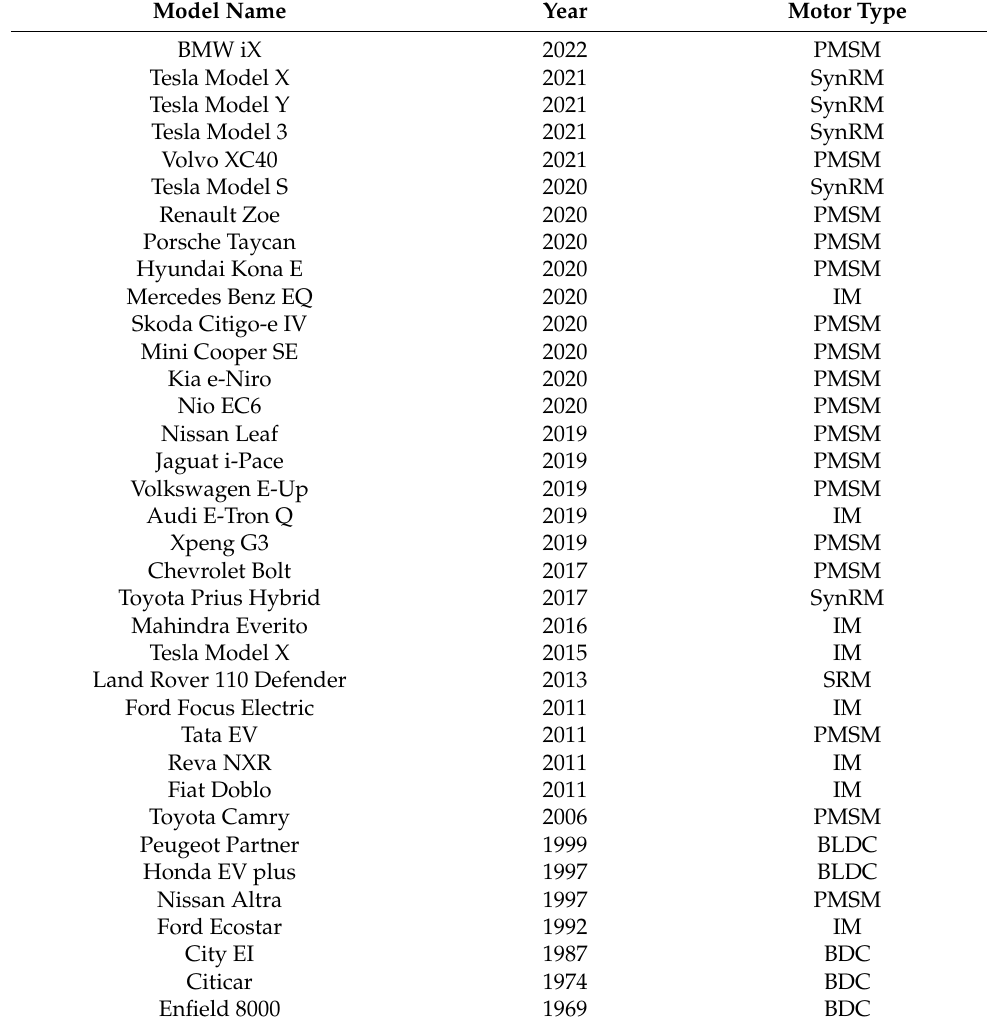
Table 6. Different motor technologies currently applied by EVs industries